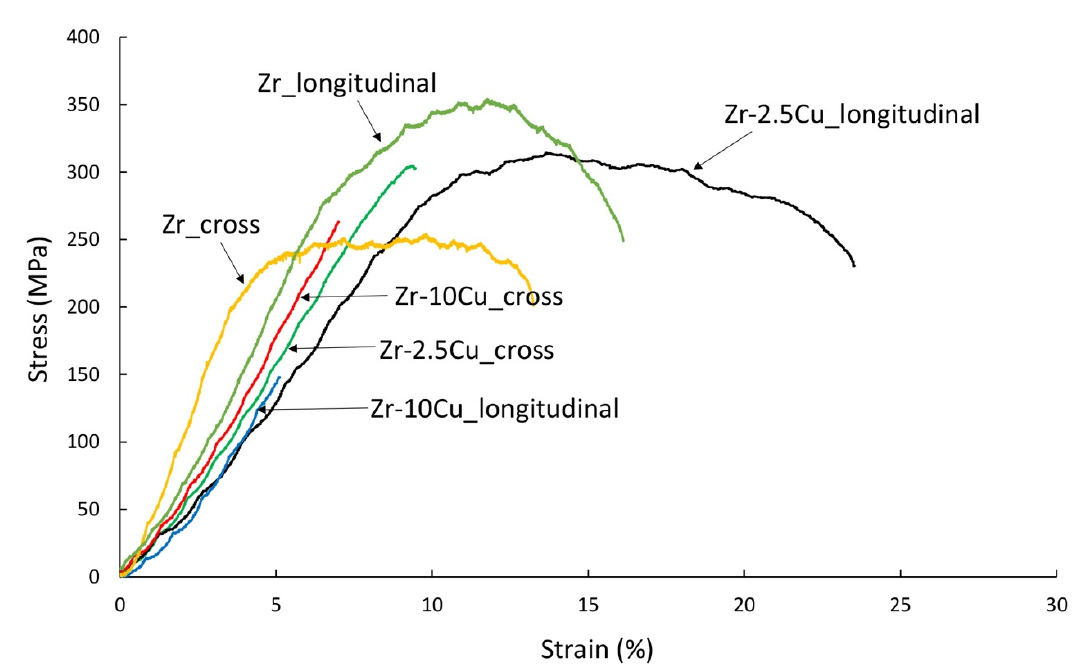
Figure 11. The results of the tensile test for the extruded samples of Zr-2.5Cu and Zr-10Cu at 400 °C. Samples were cut from materials obtained in the direction of the extrusion axis (“longitudinal”) and perpendicular to the extrusion axis (“cross”).